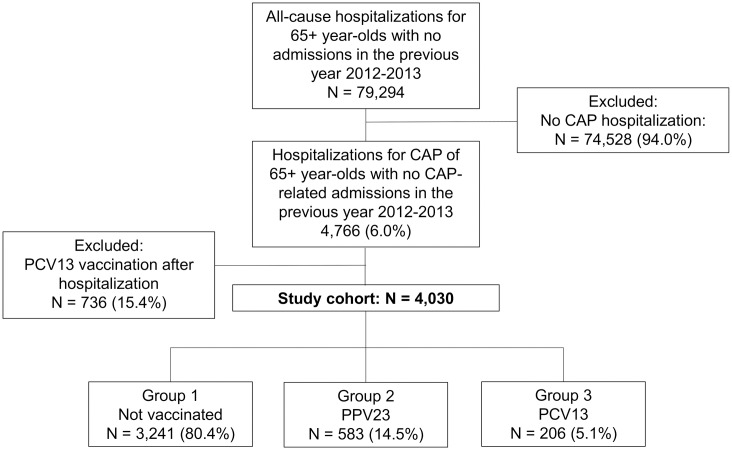
Patient selection.